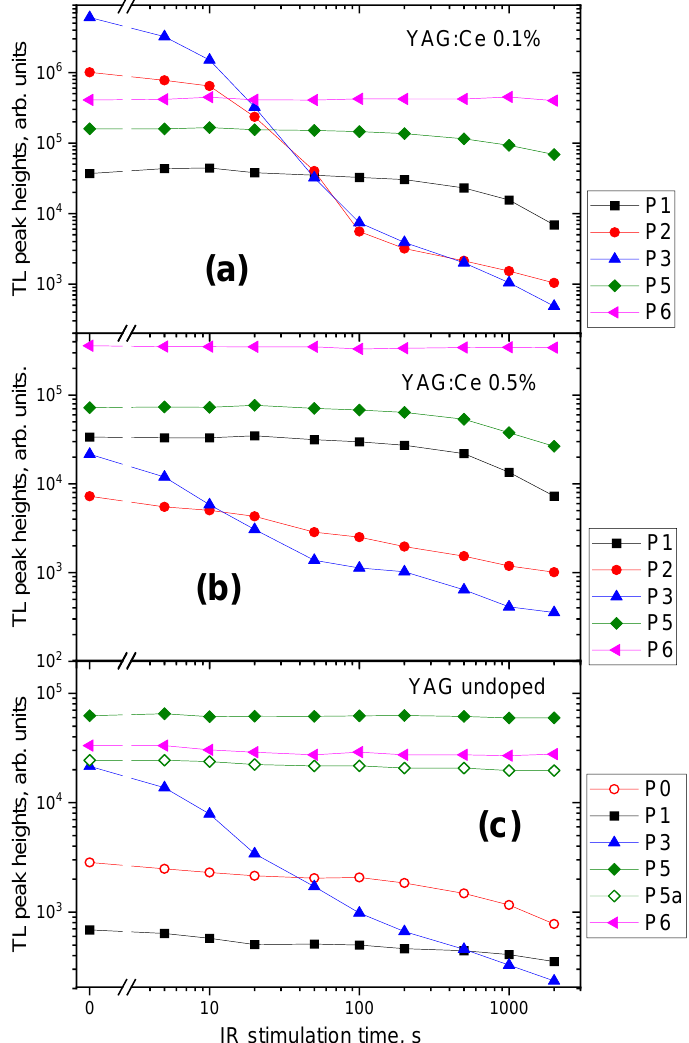
Figure 12. Dependence of the amplitude of the main TL peaks on the IR stimulation time in YAG:Ce 0.1% ( a ), YAG:Ce 0.5% ( b ), and undoped ( c ) crystals, according to the deconvolution with the first- order kinetics. It should be noted, that as peaks P2 and P3 are strongly overlapped, the separation between them is probably biased with large uncertainties.